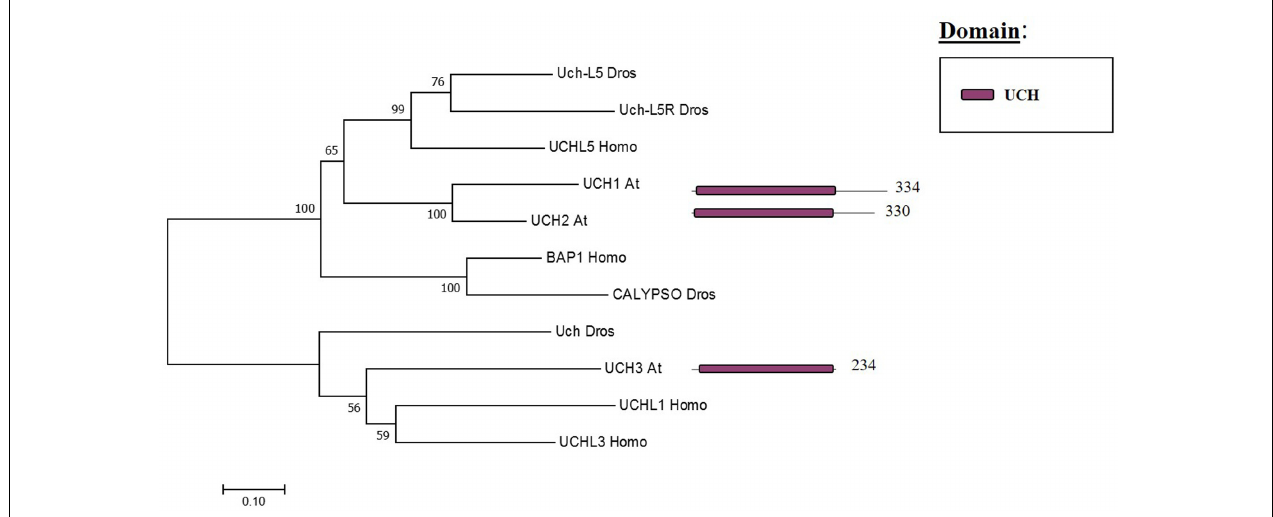
FIGURE 3 | Arabidopsis UCH family and the high sequence similarity proteins in Humans and Drosophila. Phylogenetic analysis showing the 3 members of the UCH family based on protein sequence percentage of similarity and their domains. The analysis was conducted in MEGA7 (Kumar et al., 2016). The tree was constructed by the Neighbor-Joining method with bootstrap resampling (5000 replicates). The numbers in the nodes indicate bootstrap values. The distances were computed using the Poisson method. Scale bars indicate units of the number of amino acid substitutions per site. The numbers in the domain representation indicate the amino acids